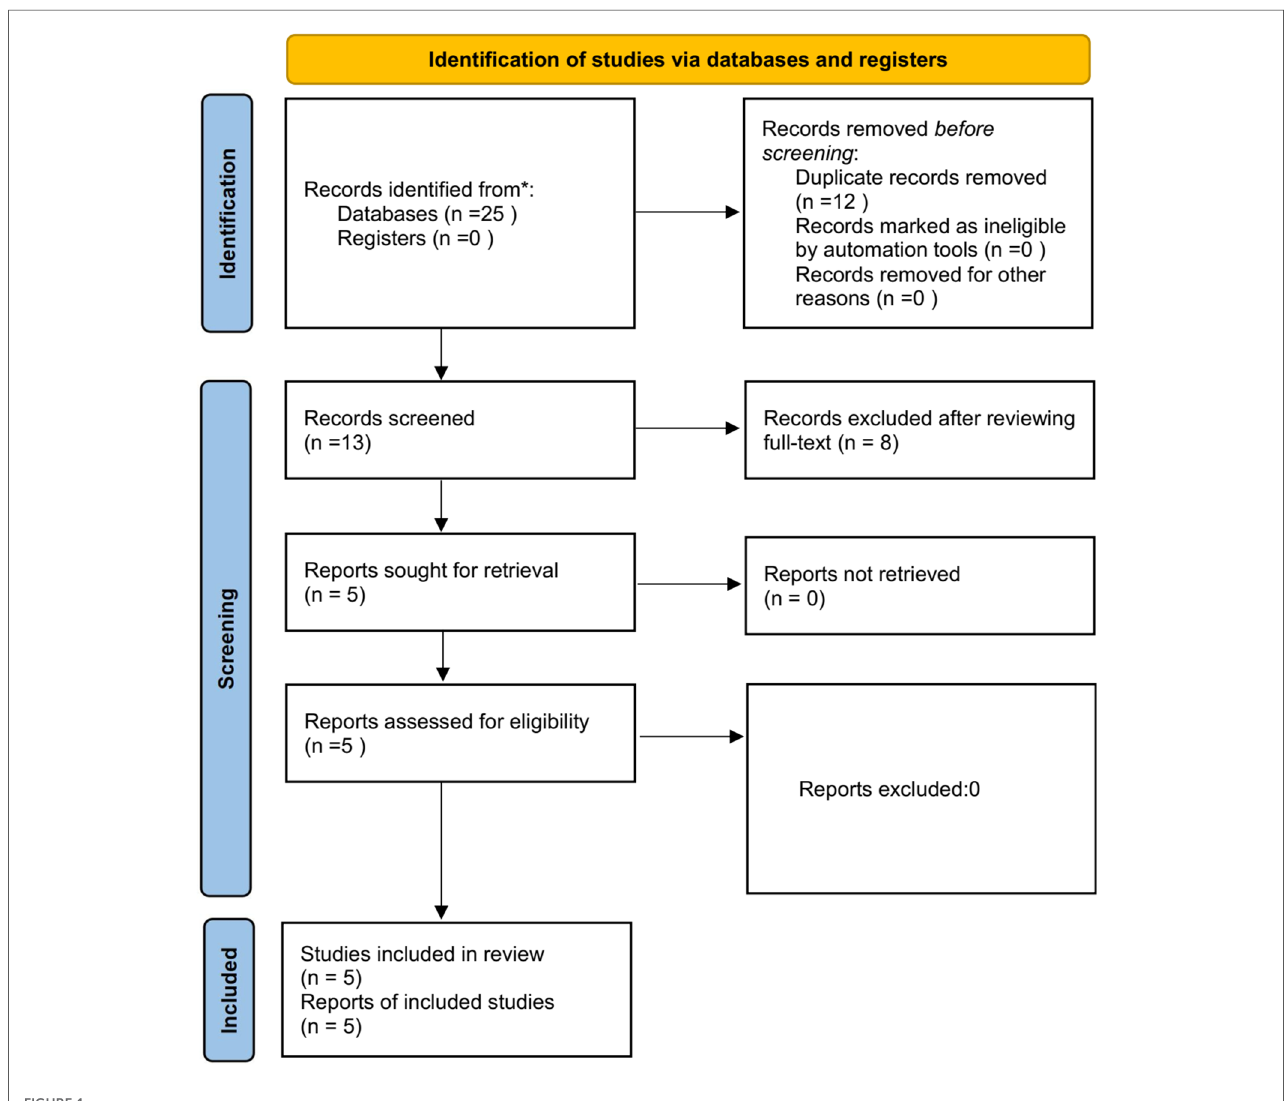
FIGURE 1 PRISMA fl ow chart.